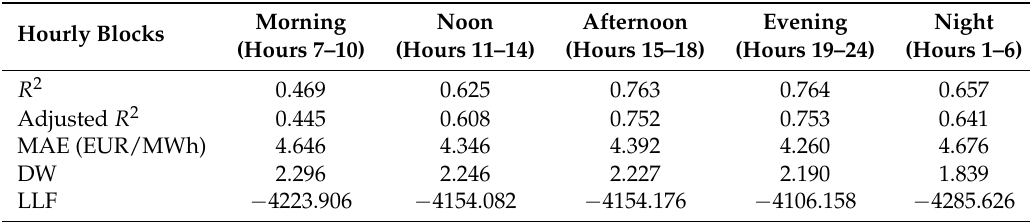
Table 9. Goodness of fit, for morning, noon and afternoon hourly blocks working days, excluding renewable energies wind and PV.